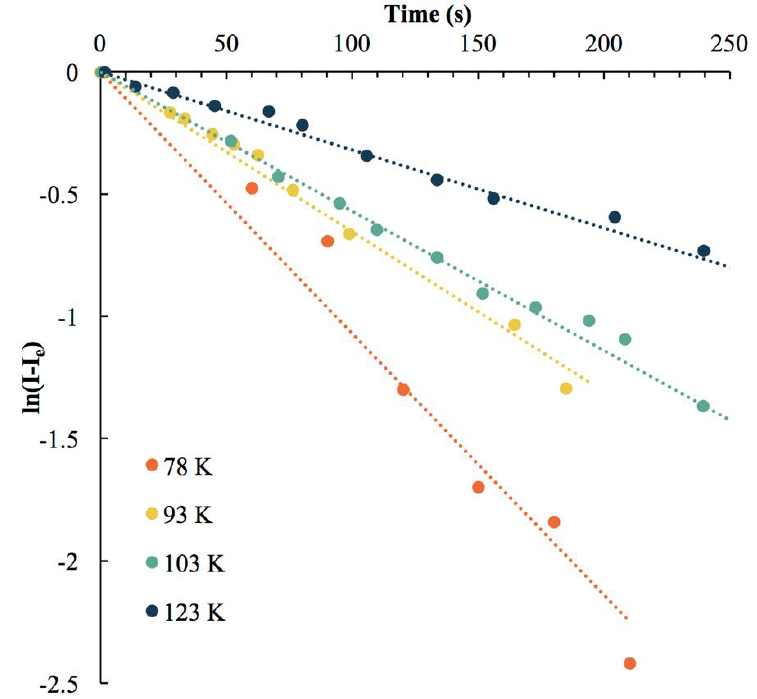
variable Figure 9. Natural log of emission intensity of 2 versus time after 255 nm laser irradiation at variable temperatures.